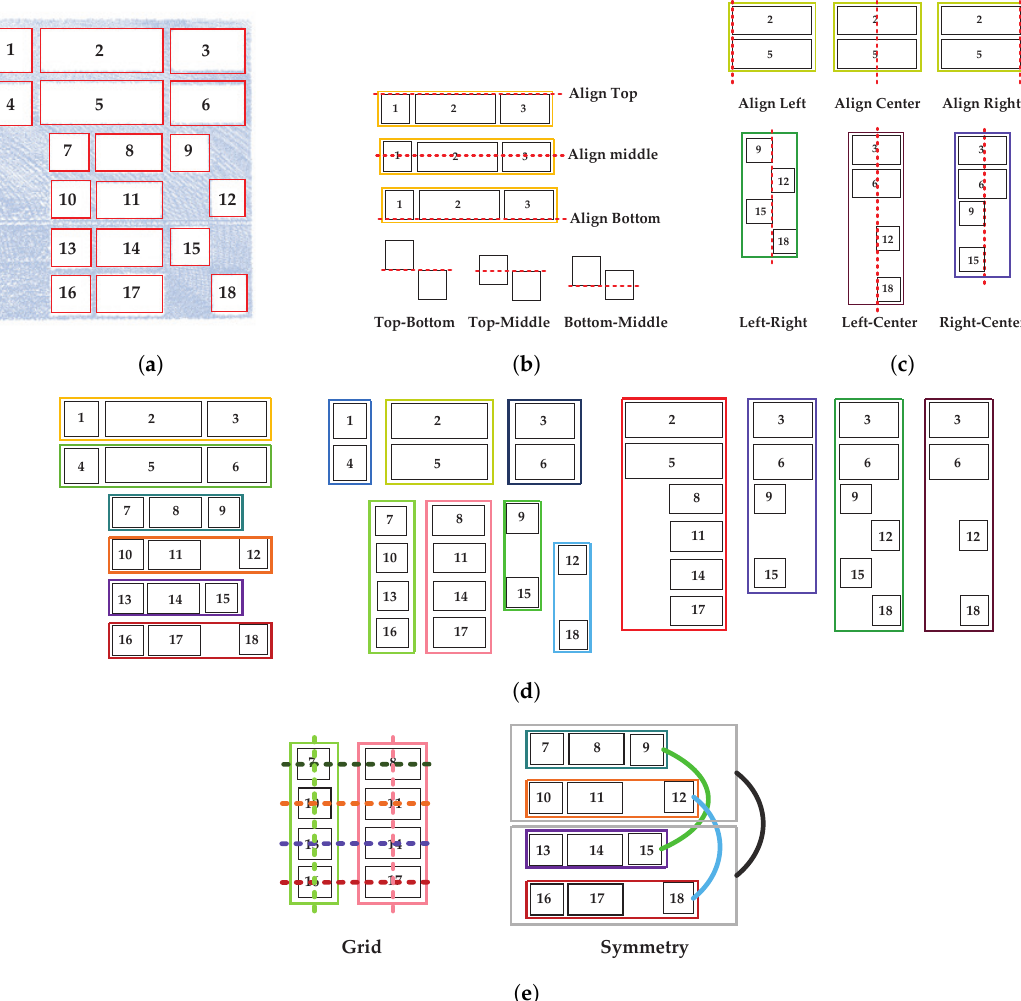
Figure 3. Flexible rules of wall openings and the presentation of their compositions. ( a ) is a facade sample with non-grid layout. The numbers in the red frames indicate the label of openings; ( b ) Horizontal alignment rules; ( c ) Vertical alignment rules; ( d ) Flexible rules in the sample layout; ( e ) Compositions of the flexible